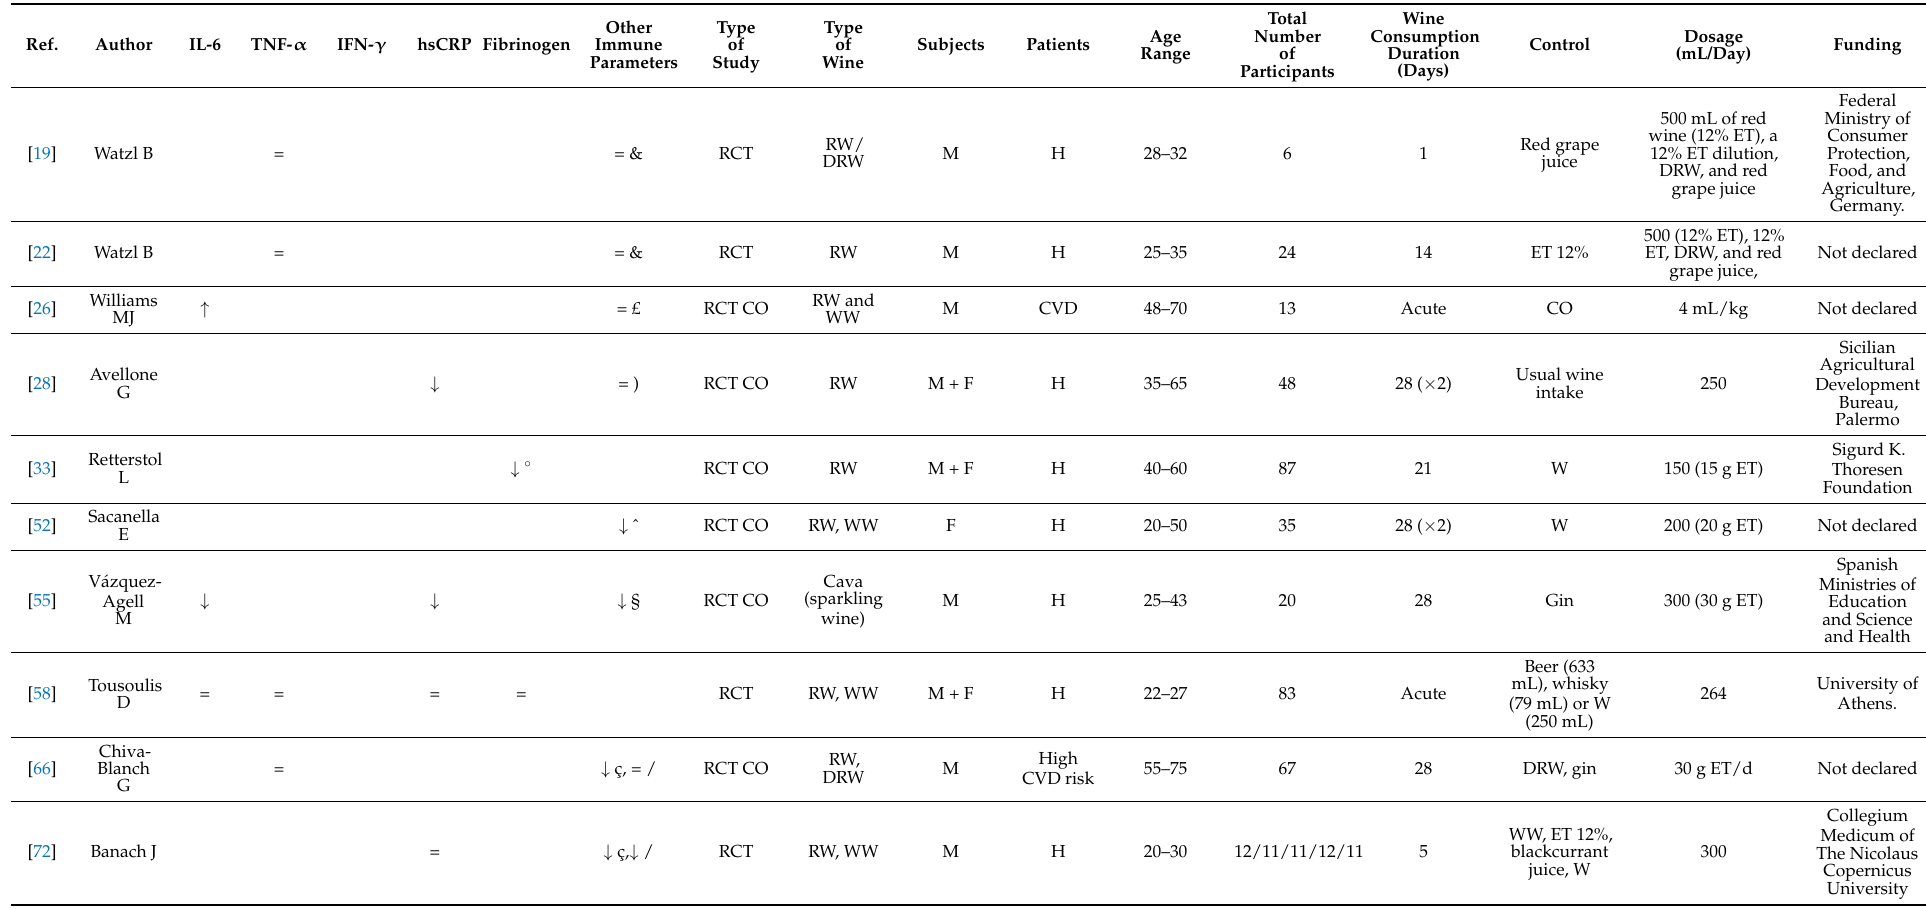
Table 6. Overview of studies that evaluated the effects of red wine consumption on immune function and inflammatory